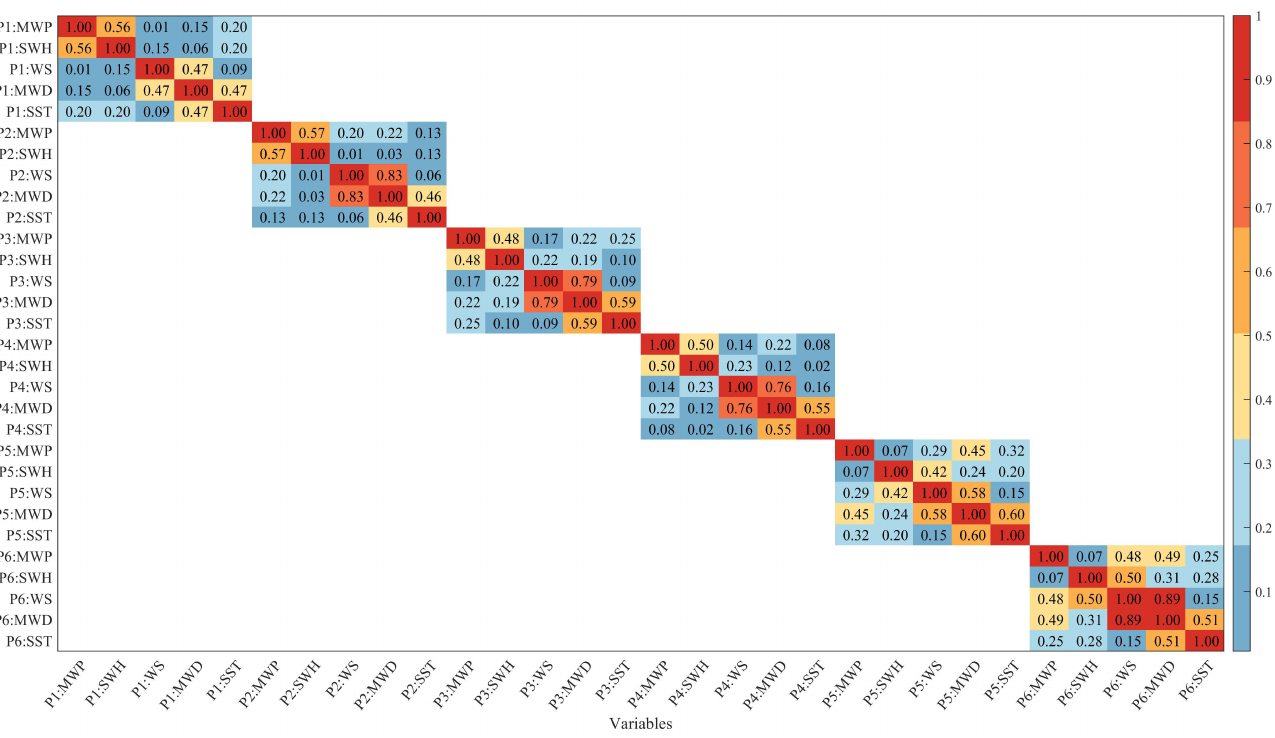
Figure 3. Correlation matrix of input variables MWP, significant wave height (SWH), wind speed (WS), mean wind direction (MWD), and sea surface temperature (SST) from P1 to P6.